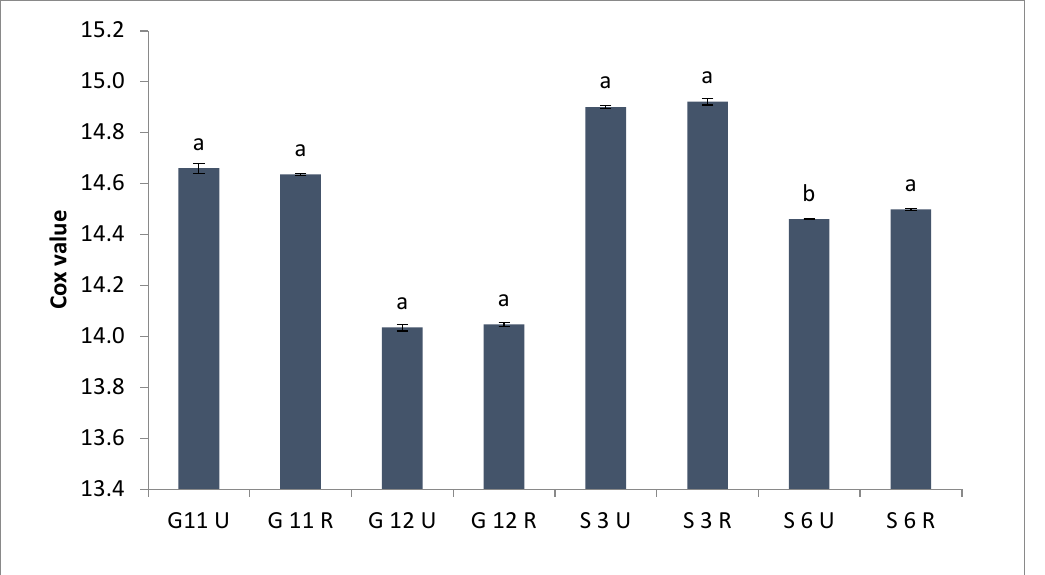
Figure 1. Cox values of oil extracted from four Egyptian unroasted and roasted linseed varieties. Values with different letters ( a , b ) are significantly different ( p <